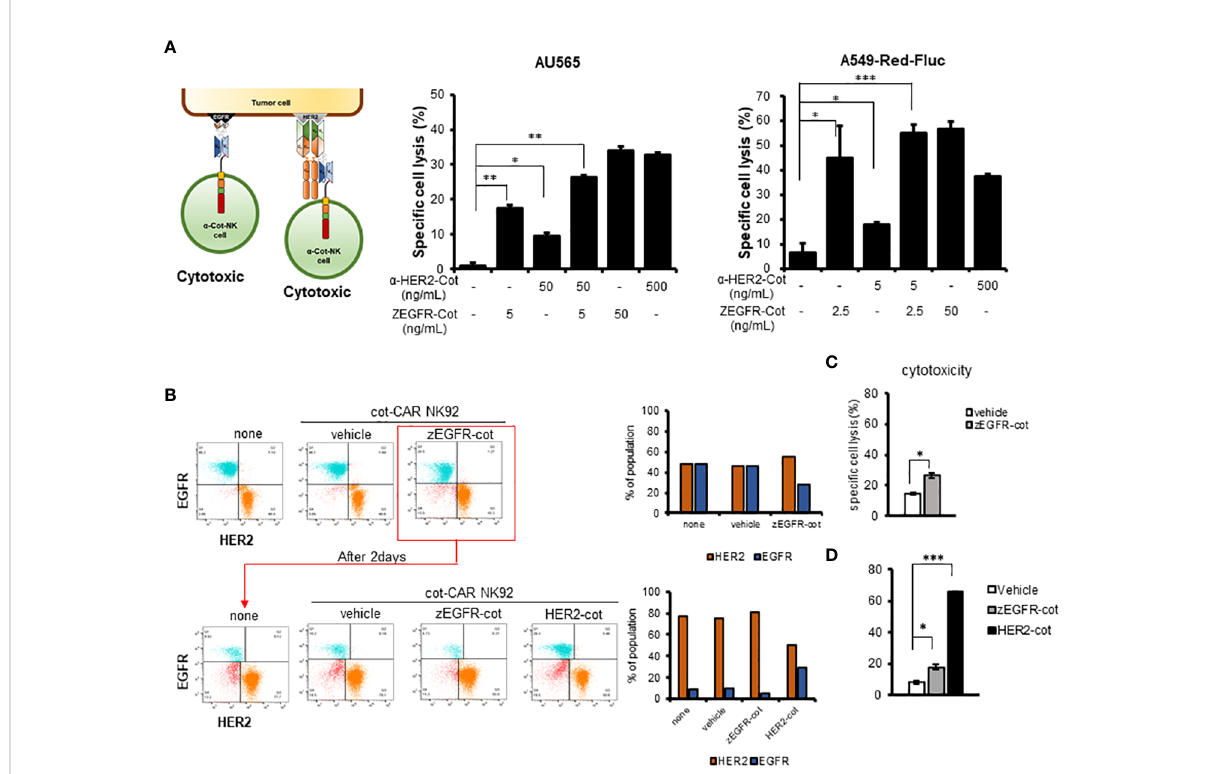
FIGURE 3 Combination with conjugator enhances recognition of multiple antigens by a -Cot-NK92 cells. (A) Additive cytotoxic effects of a -Cot-NK92 cells in multi-targeting through co-treatment with a -HER2-Cot and ZEGFR-Cot. a -Cot-NK92 cells were co-cultured with calcein-stained AU565 cells with/without a -HER2-Cot (50 or 500 m g/mL), ZEGFR-Cot (5 or 50 ng/mL), or both a -HER2-Cot and ZEGFR-Cot at a 1:1 E:T ratio for 4 h, or were co-cultured with calcein-stained A549-Red-Fluc cells with/without a -HER2-Cot (5 or 500 m g/mL) and/or ZEGFR-Cot (2.5 or 50 ng/mL) at a 5:1 E:T ratio for 4 h. (B) To mimic the heterogeneity of the recurrent tumor, the EGFR + HER2 − MDA-MB-231 and EGFR − HER2 + MDA-MB-453 cells were mixed. On day 1, one group was not treated with a -Cot-NK92 cells (none) and the other groups were co-cultured with a -Cot-NK92 cells with/without ZEGFR-Cot at a 1:1 E:T ratio for 4 h. After removing a -Cot-NK92 cells, the remaining target cells were cultured for 2 d and then co-cultured with the a -Cot-NK92 cells with ZEGFR-cot or a -HER2-cot. (C) Cytotoxicity of a -Cot-NK92 cells to tumor cells on day 1 and (D) after 2 d in a model mimicking a recurrent tumor. Population change was measured using a FACS. All cytotoxicity data are presented as the mean ± S.D. of triplicates. Statistical signi fi cance of differences between groups was evaluated using paired Student ’ s t- test. *** P < 0.001; ** P